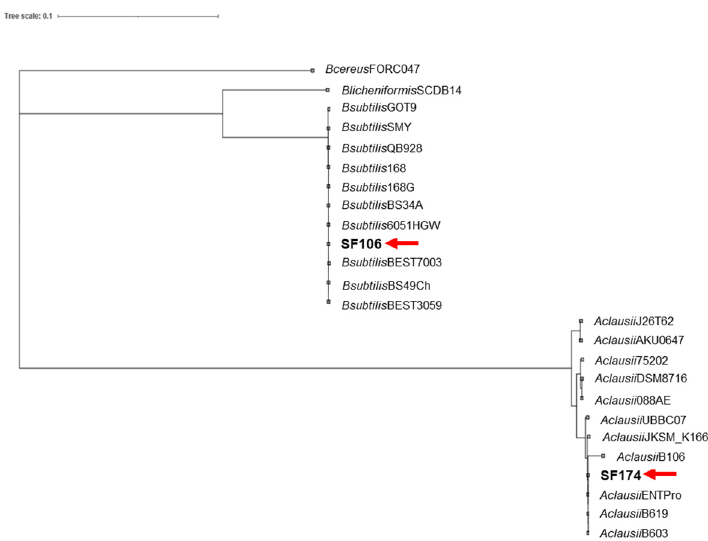
Figure 2. Phylogenetic tree of genome sequences of SF106 and SF174 (here indicated by the red arrows) and several B. subtilis and A. clausii species from NCBI, constructed using the tool GTDB. Strain names are reported. B. cereus and B. licheniformis were used as